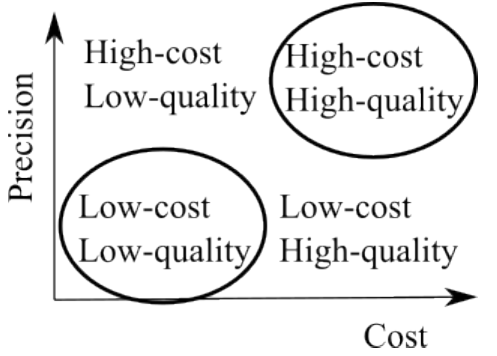
Figure 1: The circled entities are discussed in this work, and re- ferred to as low-cost and high-cost sensors for brevity. measurement units). These sensor types are relevant for many